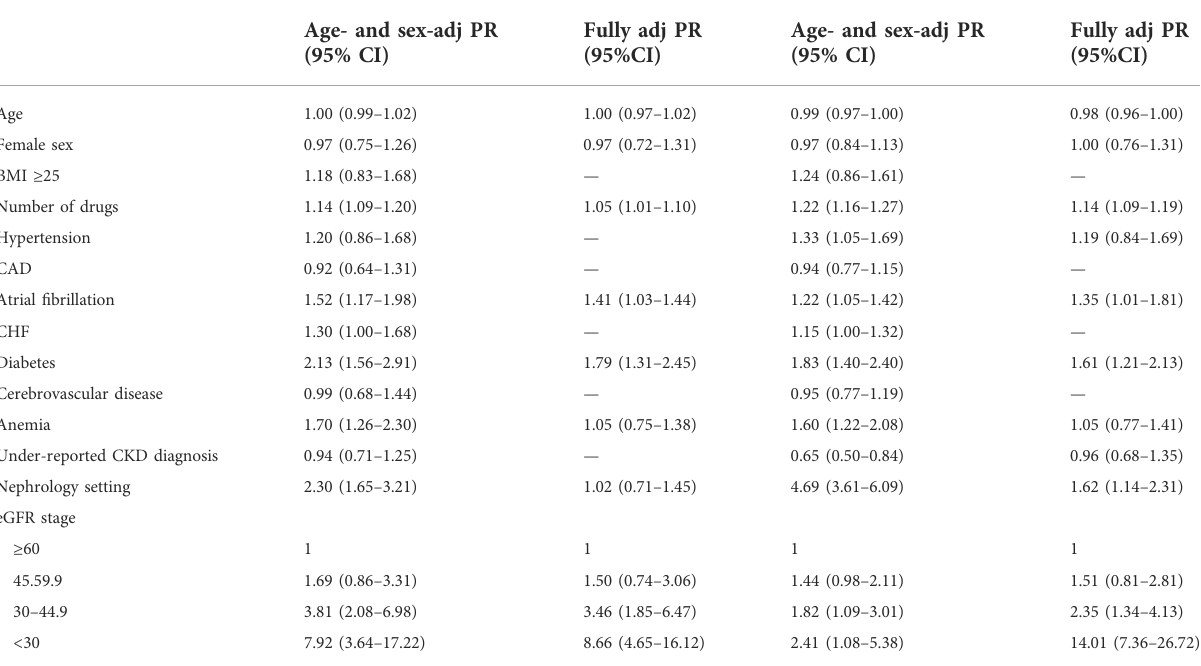
TABLE 4 Factors associated with PIMs in the overall study